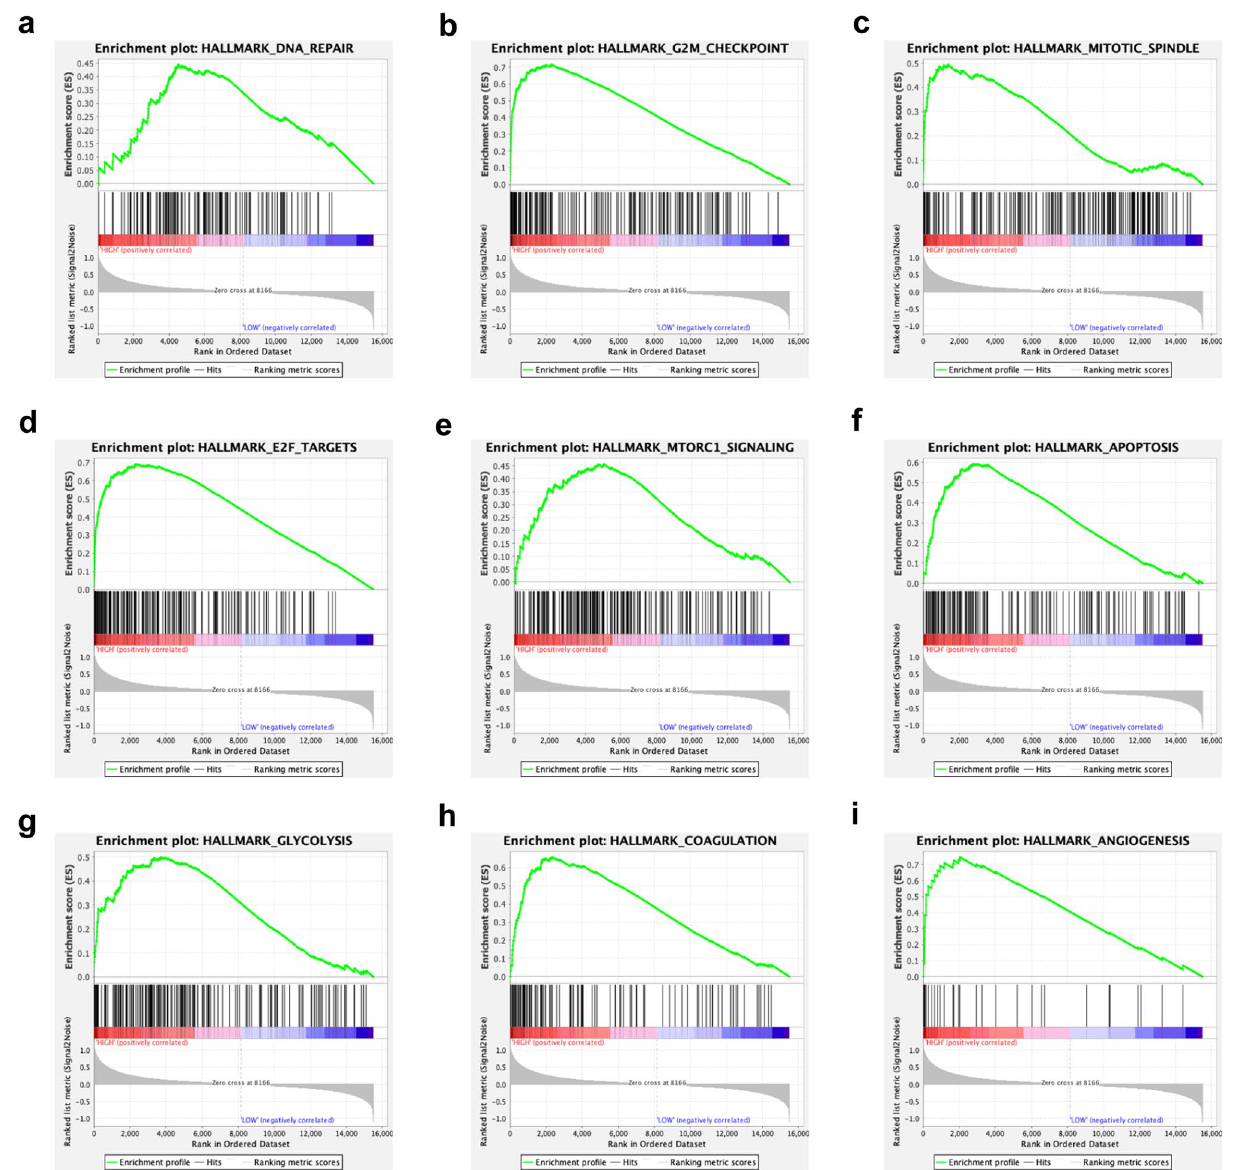
Figure 6. Functional analysis of the 14-gene signature. ( a – i ) GSEA revealed the hallmarks of malignant tumors, including DNA repair, G2/M checkpoints, mitotic spindles, E2F targets, MTORC1 signaling, apoptosis, glycolysis, coagulation and